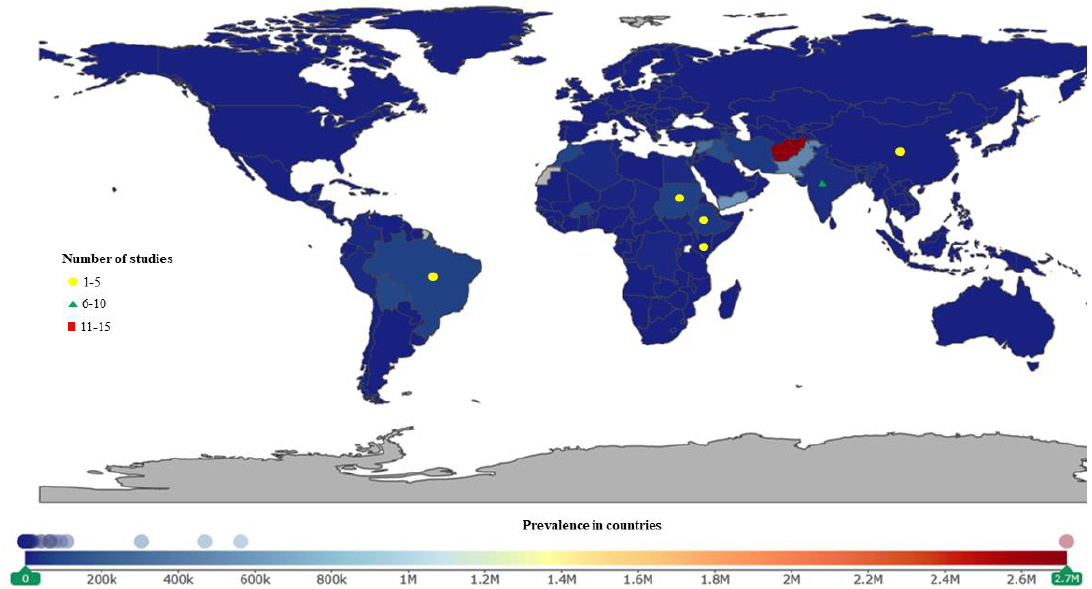
Figure 4. Leishmaniasis studies were conducted more often in Asia. India had the highest number of studies. Afghanistan, Yemen, and Pakistan have the highest prevalence.